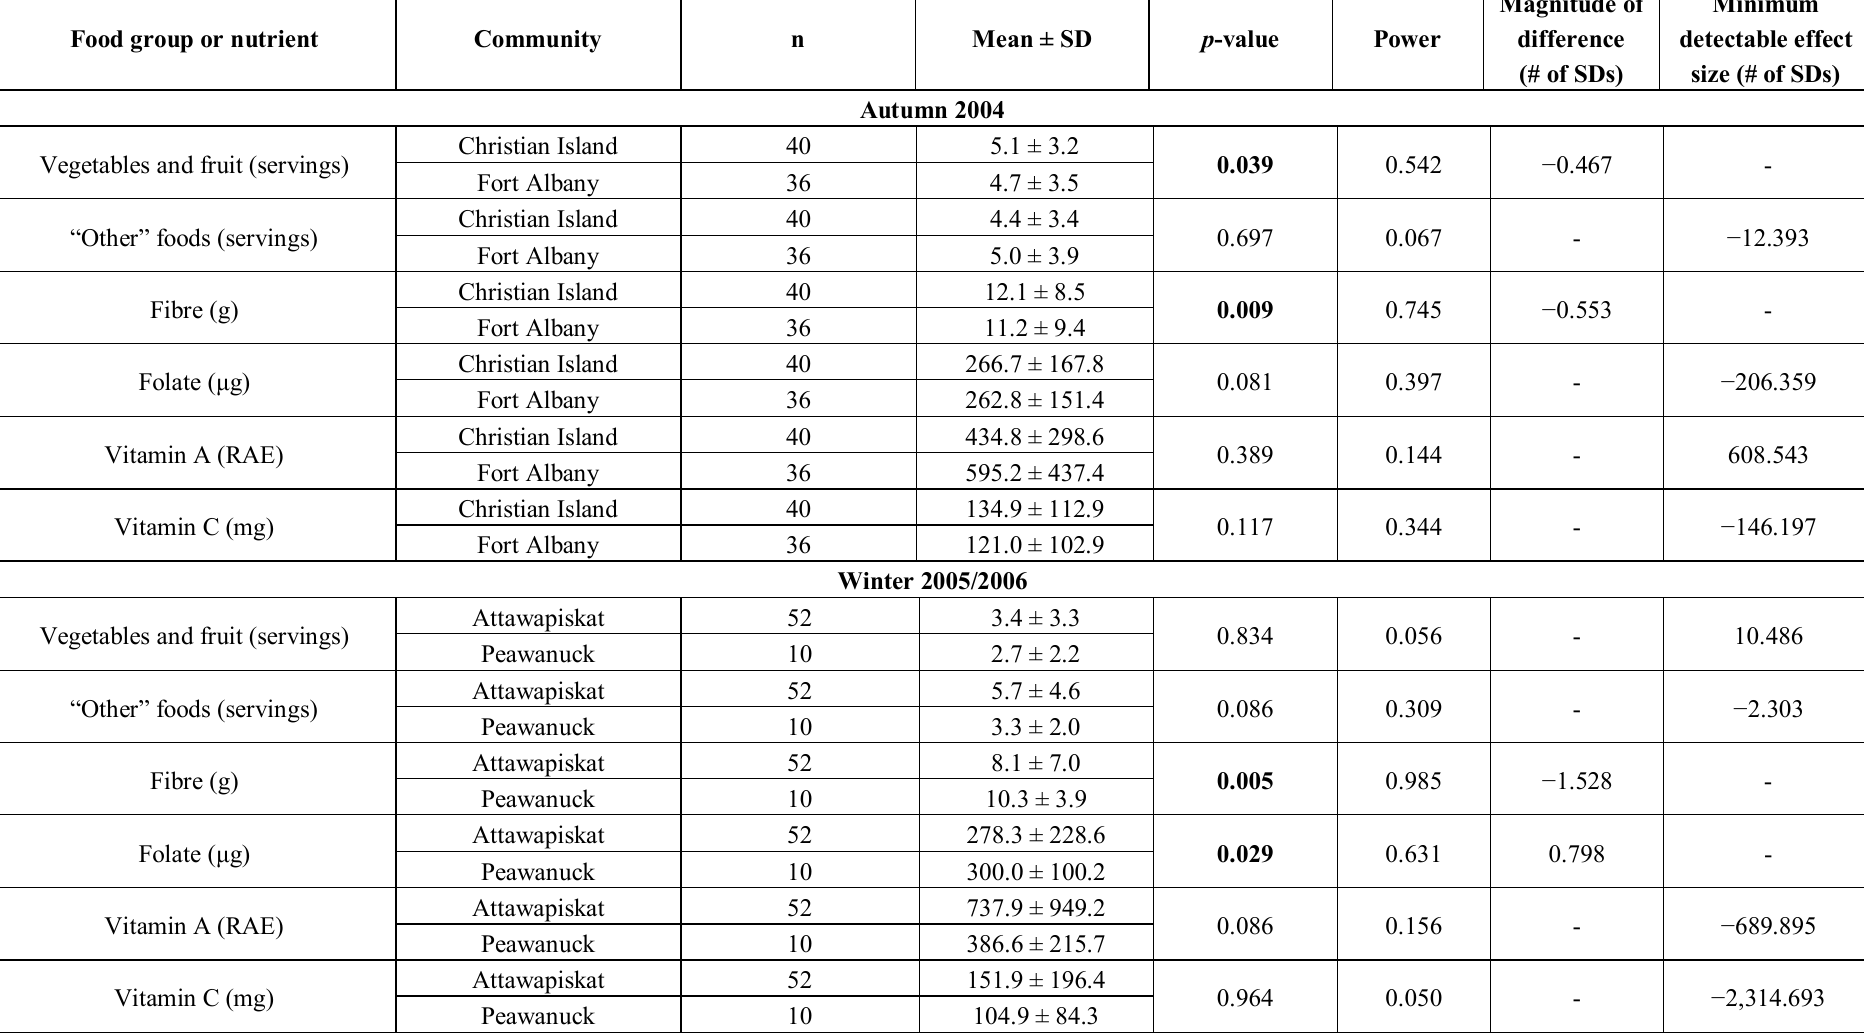
Table 6. Comparison of dietary intakes between communities a